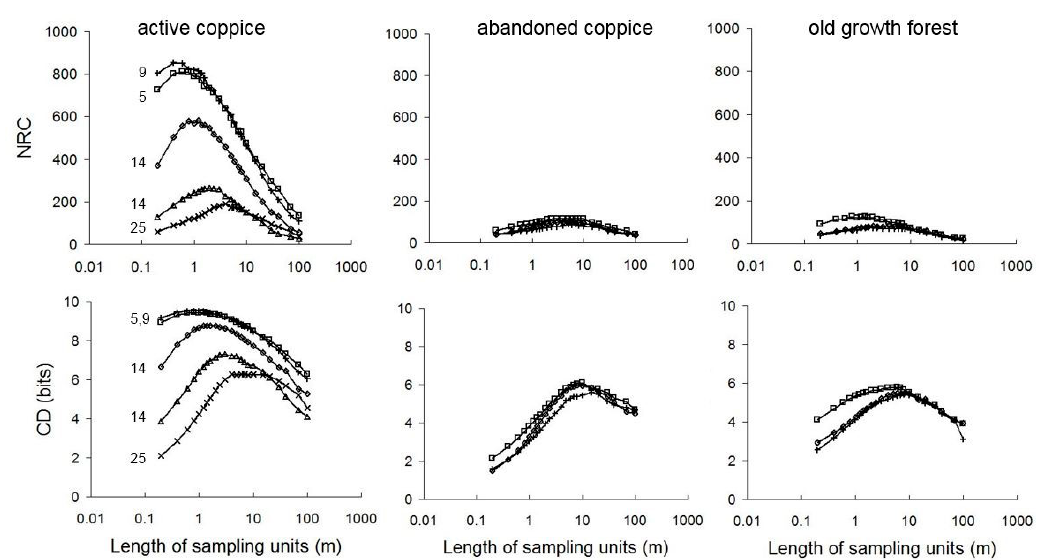
Figure 1. Scale dependence of beta diversity in beech forests. Beta diversity (spatial variability of species composition) estimated by the number (NRC) and diversity (CD) of realized species combinations. Numbers refer to ages (years after the last logging event). Note that both NRC and CD are scale dependent and show unimodal patterns with the increasing length of sampling units. Based on the peaks of these curves we delineated two representative scales (2 m and 10 m) for further analyses. At the 2 m scale, the largest mean species richness (6.99) appeared in active coppice stands, the smallest value (1.25) in abandoned coppice stands, while mean species richness was 2.08 in